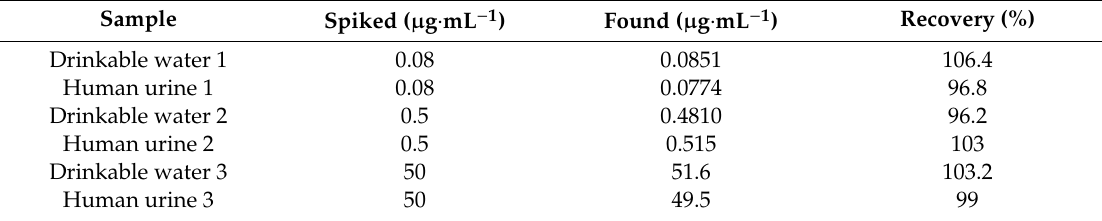
Table 2. Recovery analysis of drinkable water and human urine samples spiked with